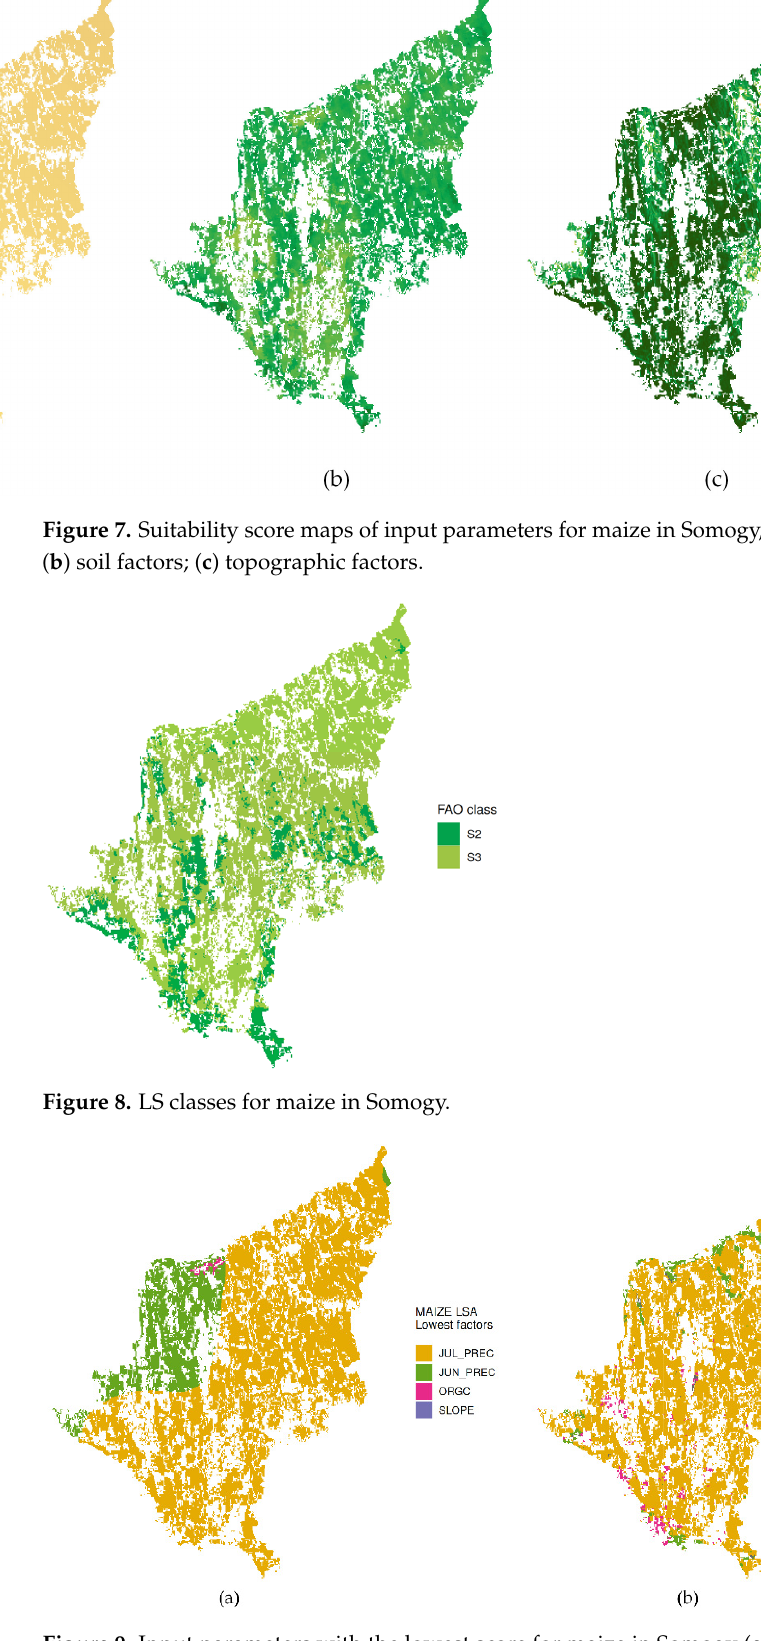
Figure 9. Input parameters with the lowest score for maize in Somogy ( a ), considering only the soil group ( b ).